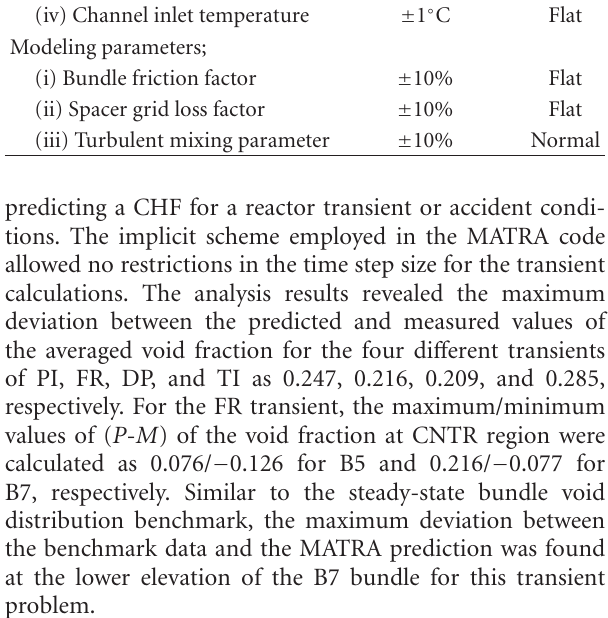
Table 5. For various operating conditions, the mean value of β was calculated as 0.08 as summarized in Table